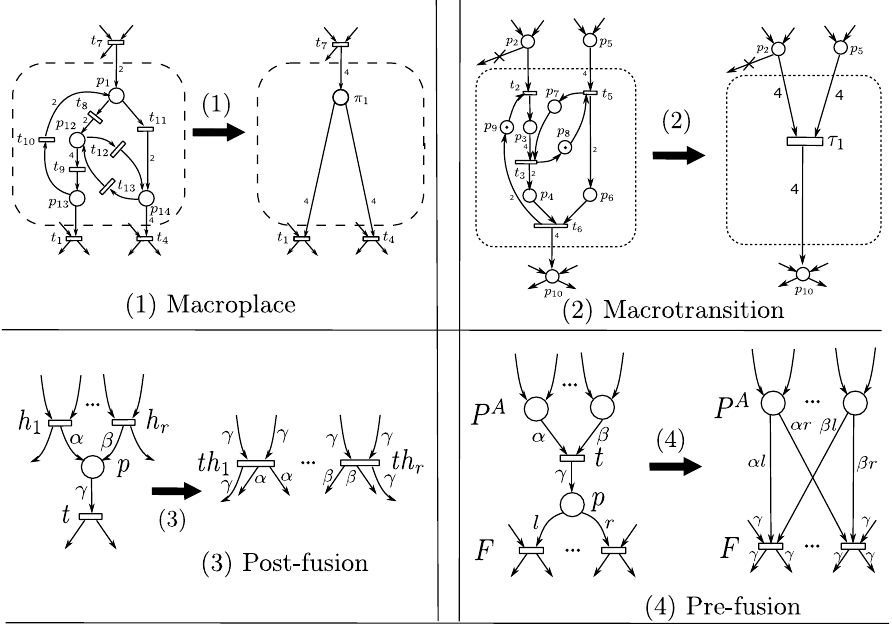
Figure 14. Particular examples of reduction rules preserving problematic configurations from